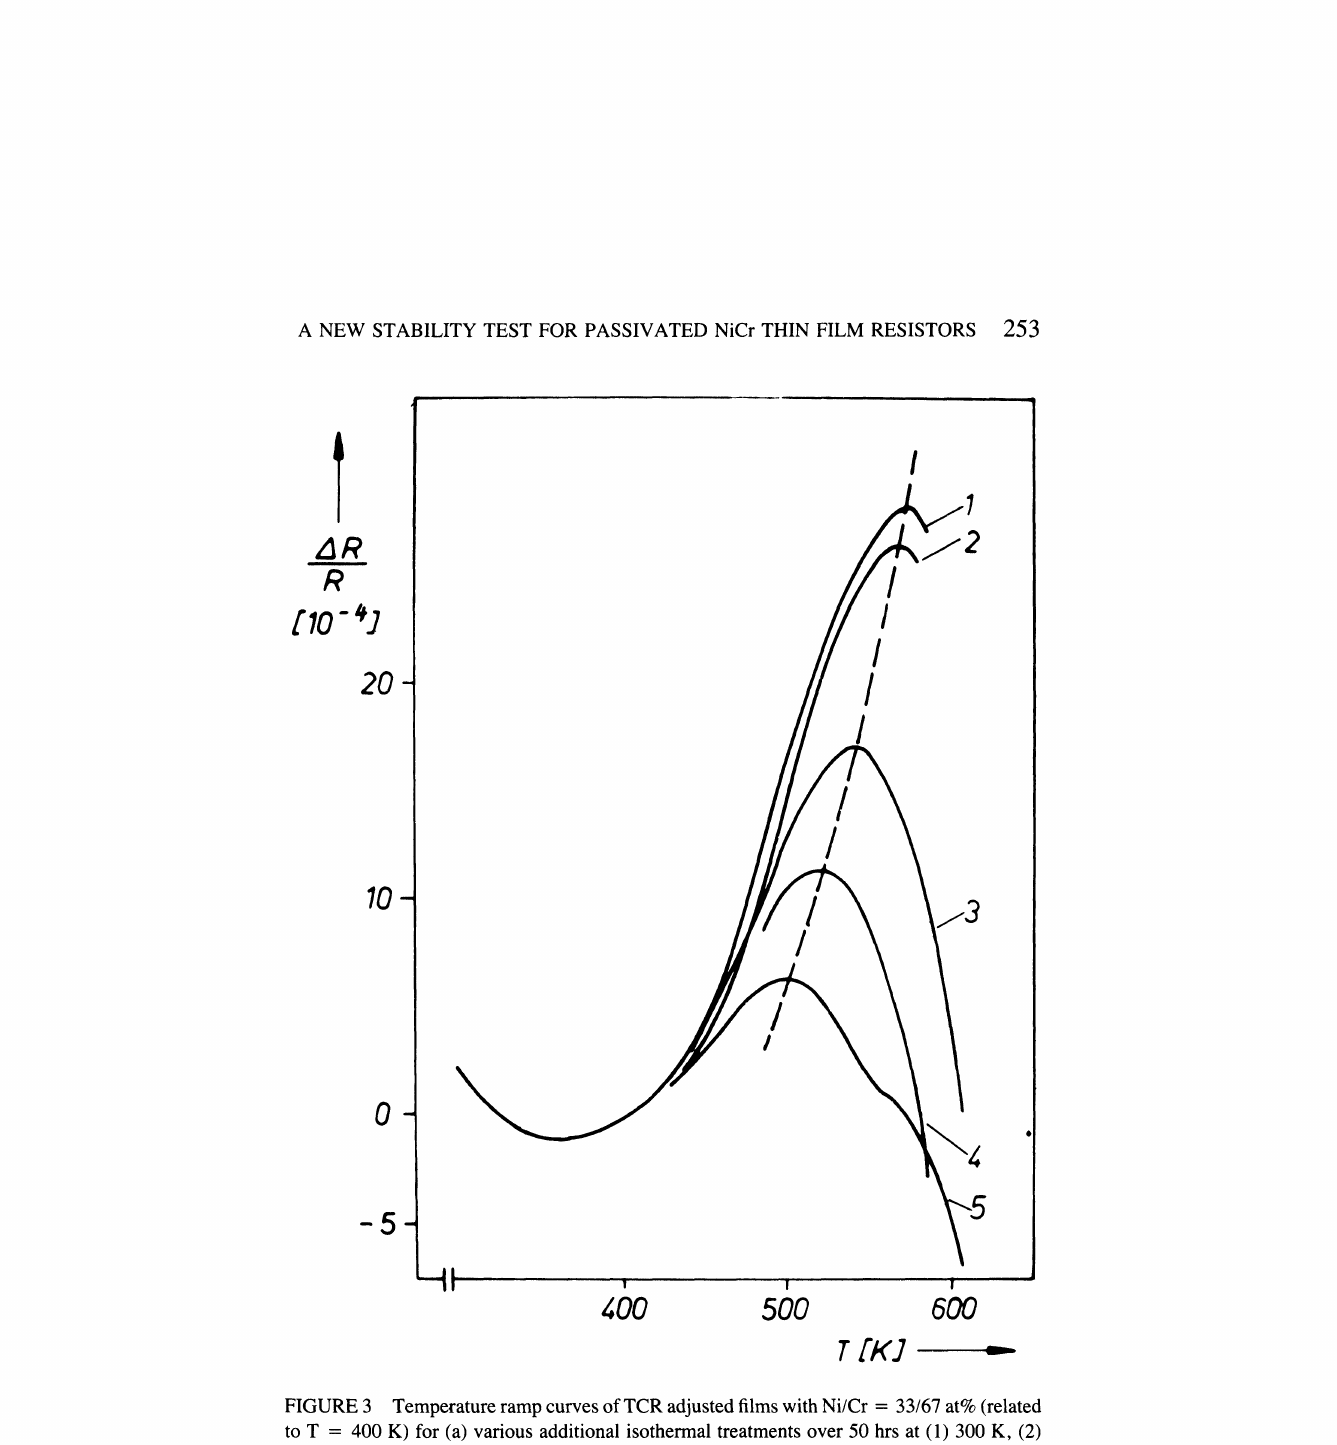
FIGURE 3 Temperature ramp curves of TCR adjusted films with Ni/Cr 33/67 at% (related to T 400 K) for (a) various additional isothermal treatments over 50 hrs at (1) 300 K, (2) 373 K, (3) 573 K, (4) 533 K, (5) 493 K; measured with 13 1.7 10 -2 Ks heating rates 13 (1) 1.7 10 -2 Ks additional isothermal treatment (493 K, 50